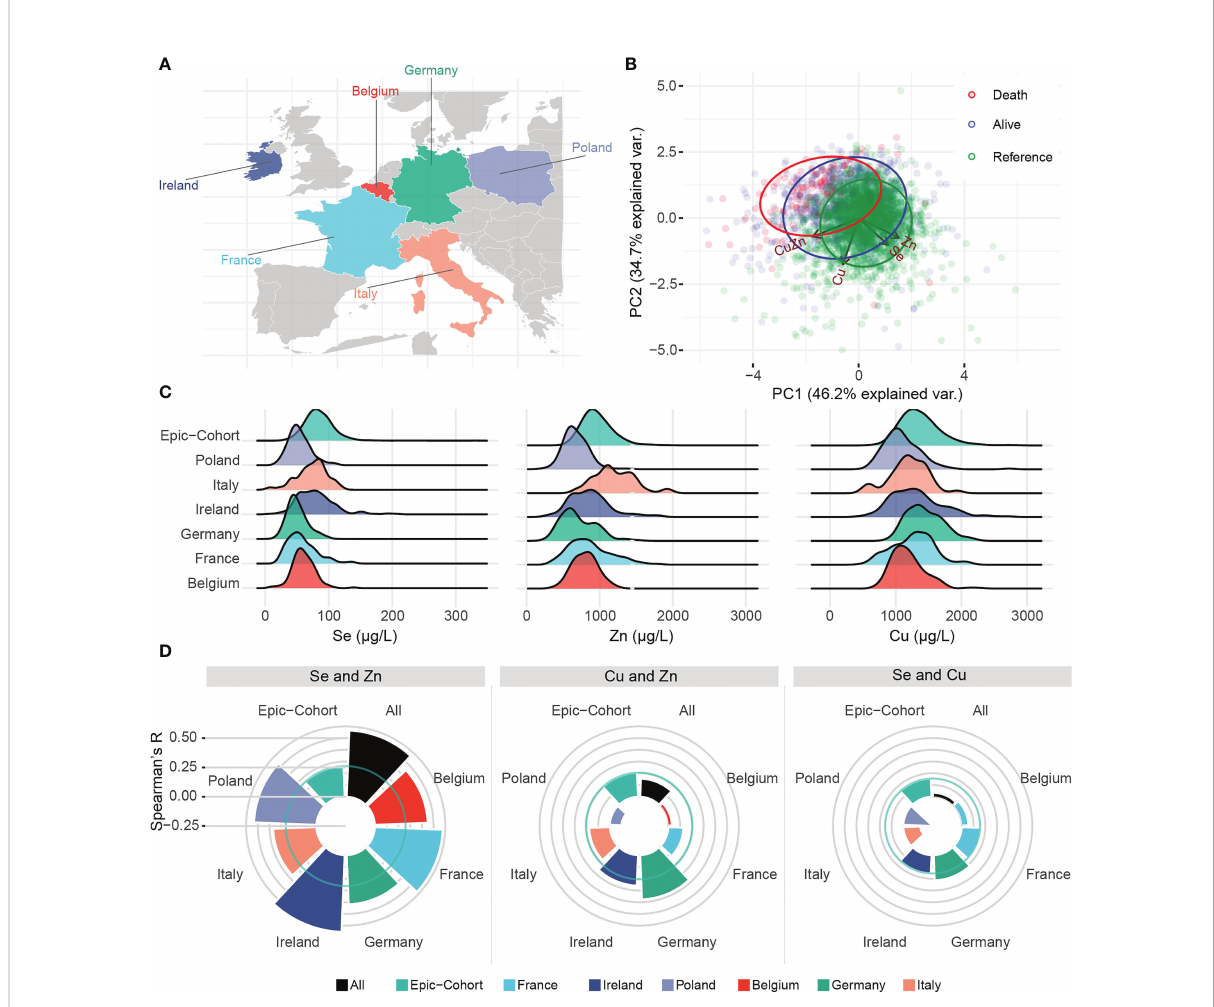
FIGURE 1 Trace element patterns and correlations. (A) Map displaying the countries contributing to this study. (B) Biplot of principal component analysis displaying patterns of trace elements, and Cu/Zn ratio in relation to clusters of alive, deceased and healthy subjects. (C) Ridgeline plot displaying the distribution of each trace element in each country as well as the healthy EPIC reference. (D) Spearman ’ s R for correlation between trace elements in each country. Solid circular green lines represent the correlations in the reference group, i.e. a representative sample of the